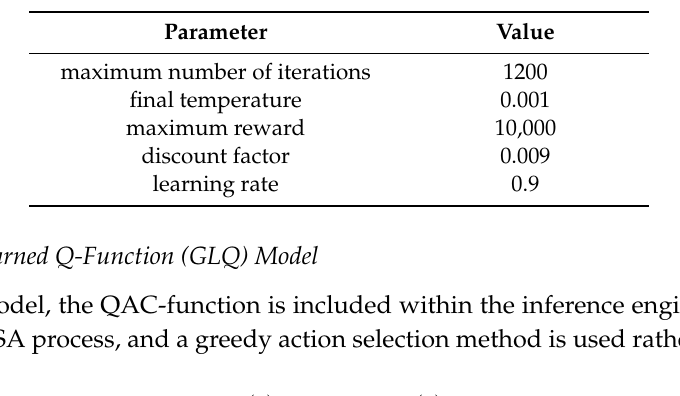
Table 2. The most relevant parameters and their values.